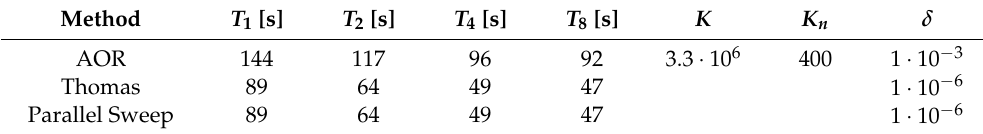
Figure 2. ( a ) Approximate solution (cid:101) U ( x , t ) of Problem 2 obtained by the Thomas algorithm; ( b ) exact (solid line) and approximate (dots) solutions at several time levels. Table 2. Results of experiments for Problem 2 with grid m = 8192, N =